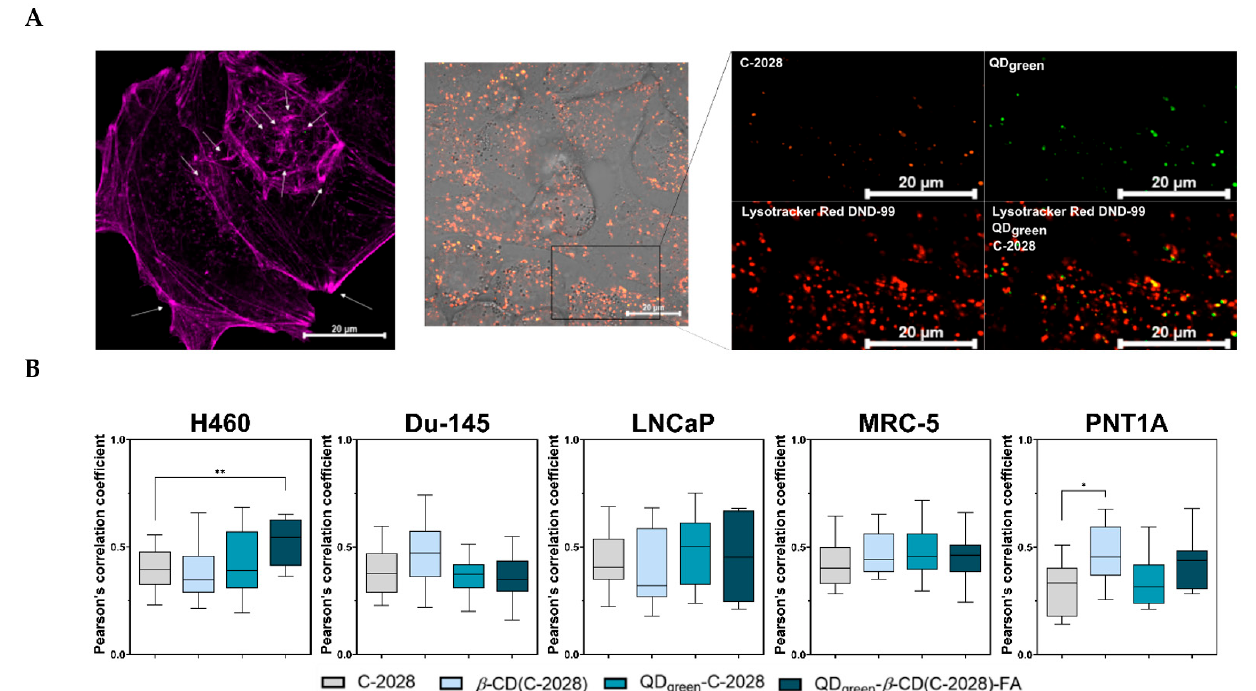
Figure 5. ( A ) Confocal images presenting localization of QD green - β -CD(C-2028)-FA in H460 cancer cells following 72 h of treatment. Acidic organelles are stained with Lysotracker Red DND-99 (red), F-actin in violet. C-2028 and QD green are depicted in orange and green, respectively. The arrows indicate signals from C-2028 and QD green . The scale bar is 20 μ m. ( B ) Pearson’s correlation coefficient of colocalization of unbound C-2028 and its nanoconjugates ( β -CD(C-2028), QD green -C-2028, and QD green - β -CD(C-2028)-FA) with acidic organelles in H460, Du-145, LNCaP, MRC-5, and PNT1A cells. Data are expressed as the mean ± standard deviation, n = 27. The results were analyzed by one-way ANOVA with Dunnett’s multiple comparisons vs. unbound C-2028, * p < 0.05, ** p < 0.01.